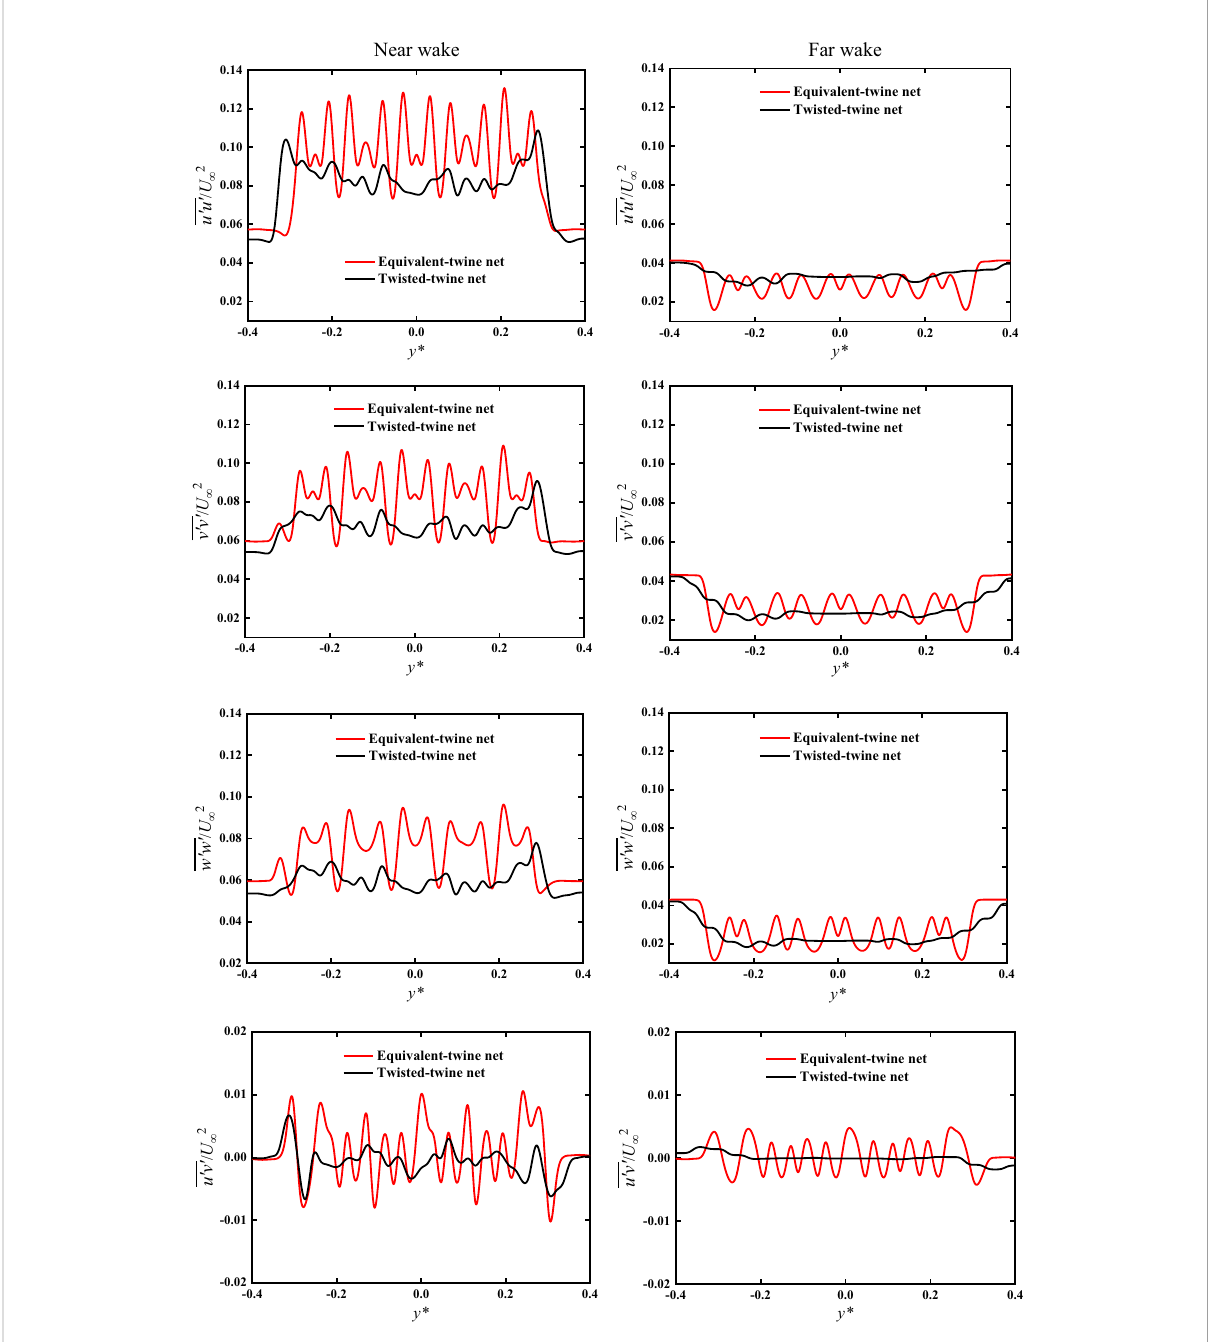
FIGURE 10 Pro fi les of the normal and shear Reynolds stress components in the near- and far-wake regions “ * ” means the dimensionlessization of y. y*=y (m)/1(m) , ” m ” means Unit of length –